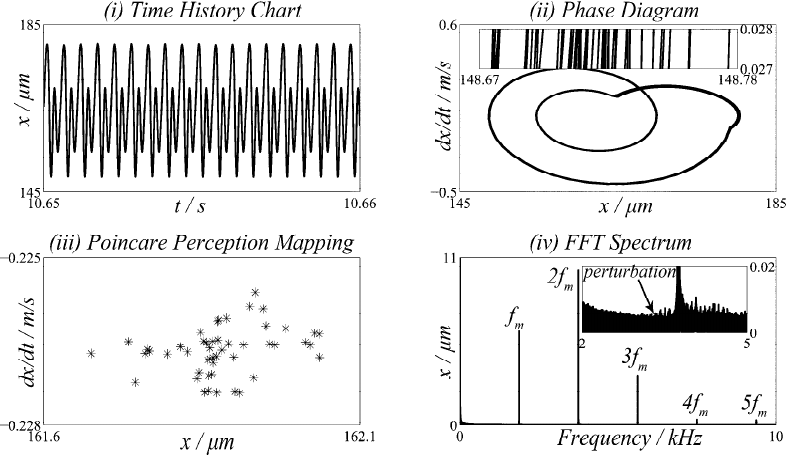
Figure 9. The system response in terms of the dynamic transmission error for b = b min .